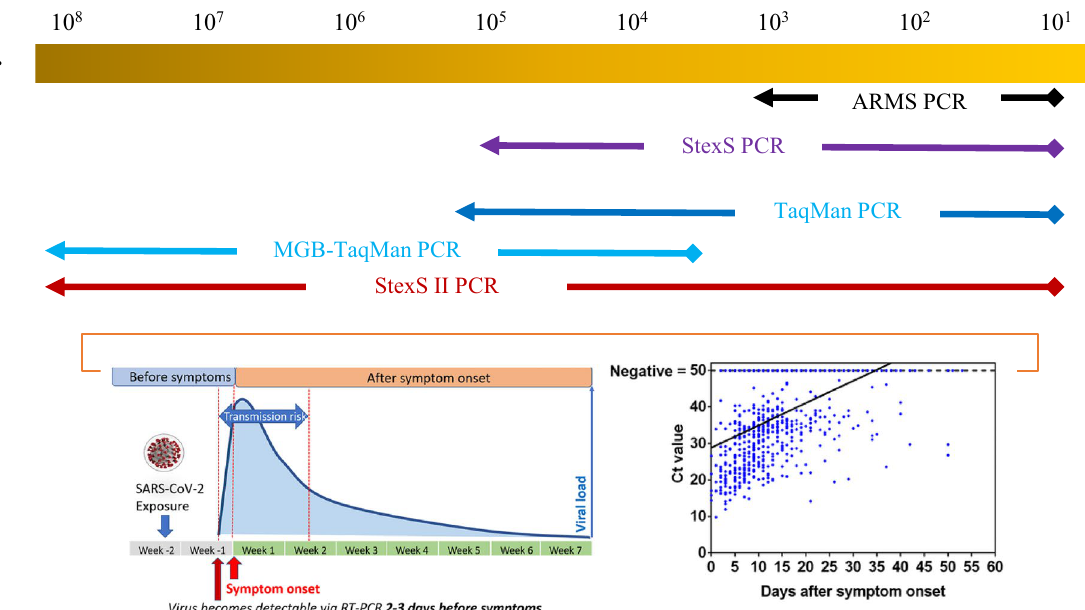
Figure 1. Comparison between methods of PCR viable in various DNA concentrations and characteristics of SARS-CoV-2 as an RNA-based environment. Clinical significance of SARS-CoV-2 RT-PCR results adapted from Reanalytical Issues and Cycle Threshold Values in SARS-CoV-2 Real-Time RT-PCR Testing: Should Test Results Include These? By Ilka Engelmann et al. (2021), ACS Omega 6 (10),